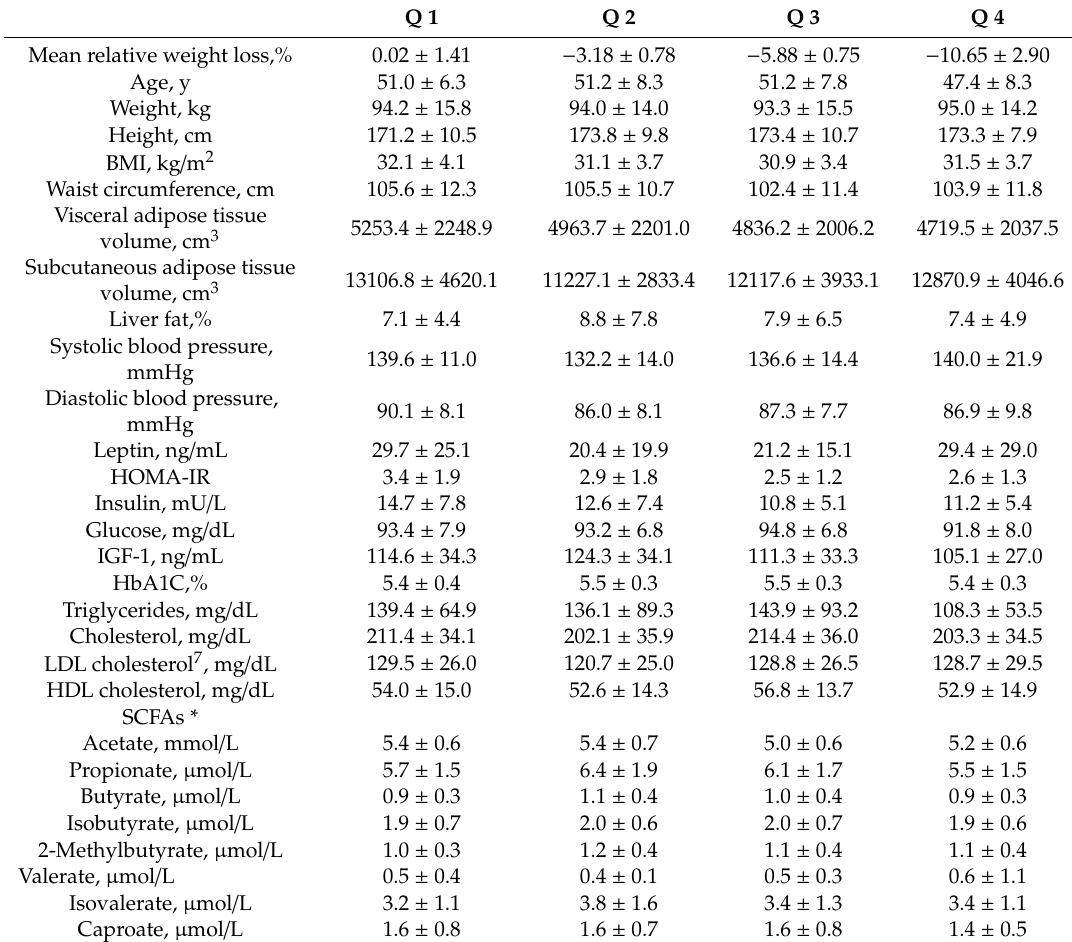
Table 1. Baseline Characteristics of the Trial Participants across Quartiles of Weight Loss over 12 weeks 1